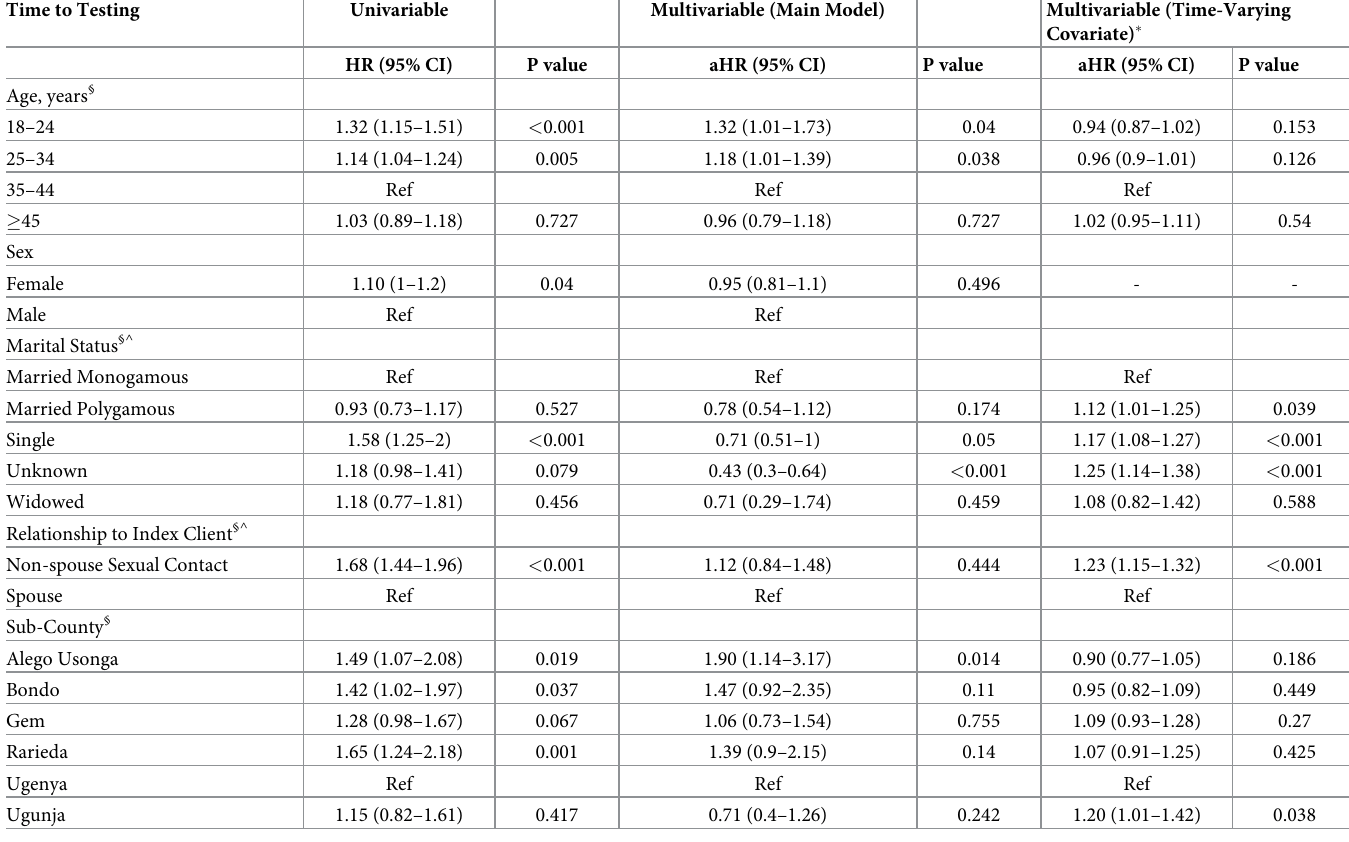
Table 3. Cox proportional hazards regression analysis of time to HIV testing among sexual contacts of HIV-positive index clients in Siaya County,